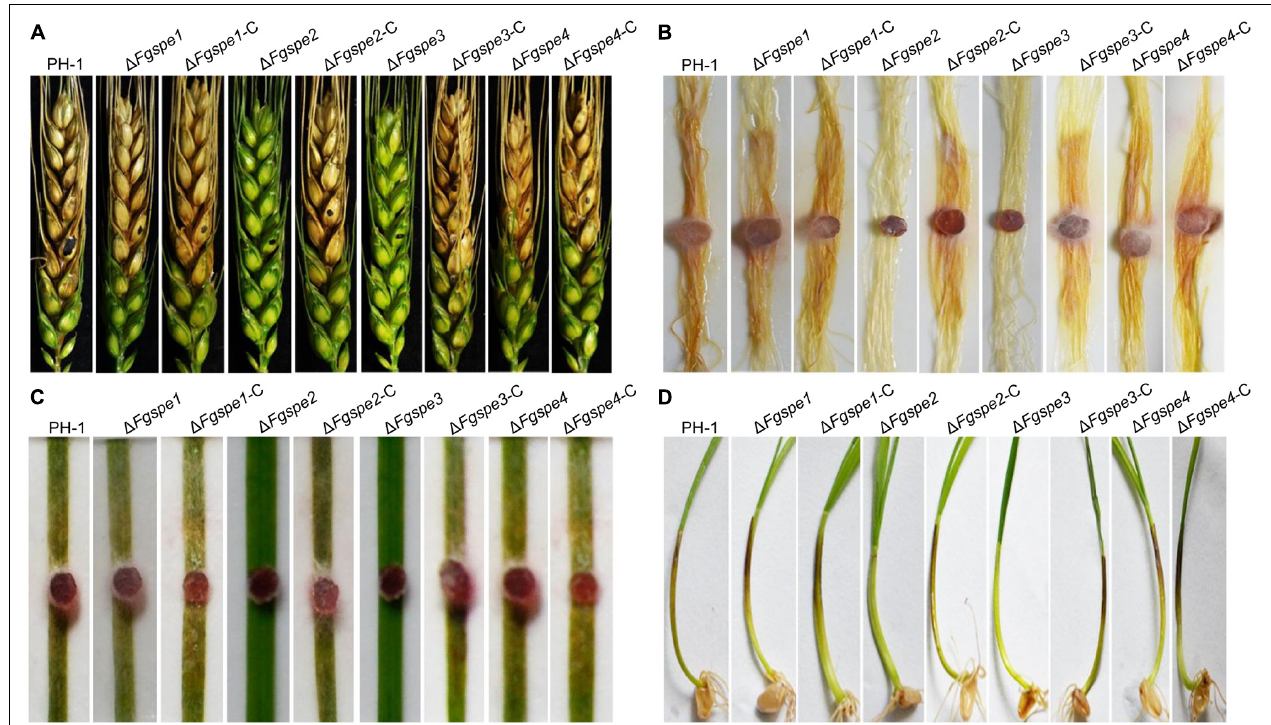
FIGURE 6 | (cid:49) Fgspe2 and (cid:49) Fgspe3 mutants have attenuated virulence in plant. (A) Pathogenicity of all tested strains on flowering wheat heads. Wheat heads were photographed at 15 days post-inoculation using a conidial suspension. The injection sites were denoted as black dots. (B) The (cid:49) Fgspe2 and (cid:49) Fgspe3 mutants also showed significantly reduced virulence on corn silks. Corn silks were inoculated with fresh mycelial plug of each strain and were determined after 5 days post-inoculation at 25 ◦ C. (C) Disease symptoms infected by the tested strains on young wheat leaves. The images were photographed at 6 days. (D) Pathogenicity of the wild-type, mutants, and complementation strains to wheat coleoptiles for 7 days.